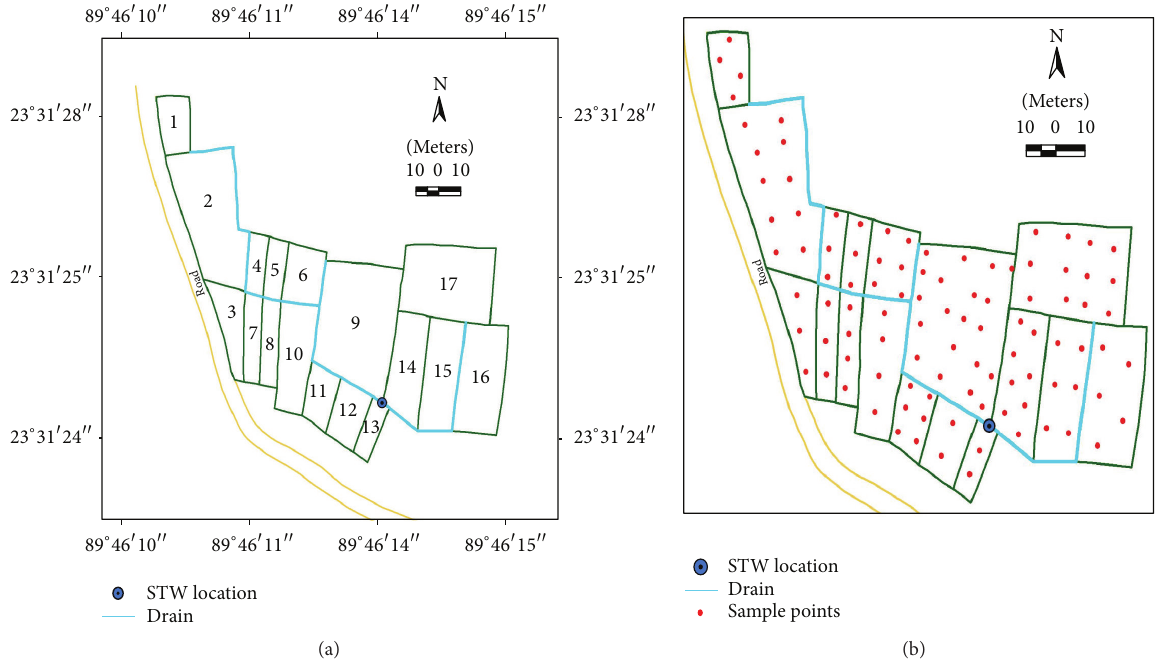
Figure 2: The base map (a) and distribution of the sample points (b) in Kanaipur command area, Faridpur Sadar Upazila.